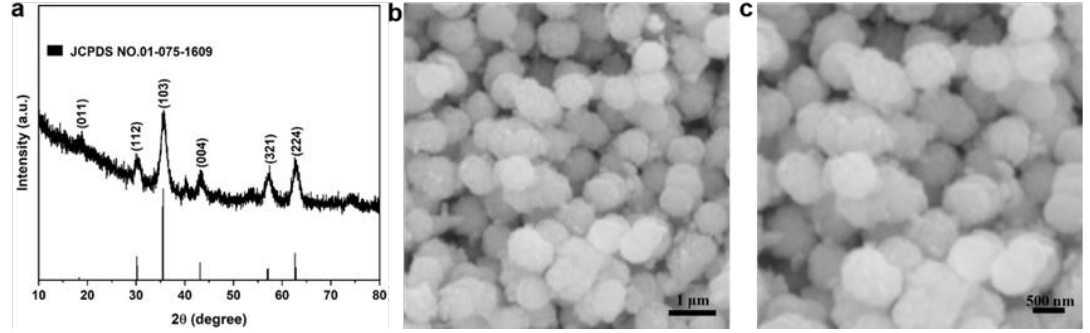
Figure 2. ( a ) XRD pattern of Ni-Pd/Fe 3 O 4 and standard card JCPDS No. 01-075-1609. ( b , c ) SEM images of Ni-Pd/Fe 3 O 4 yolk-shelled nanospheres.